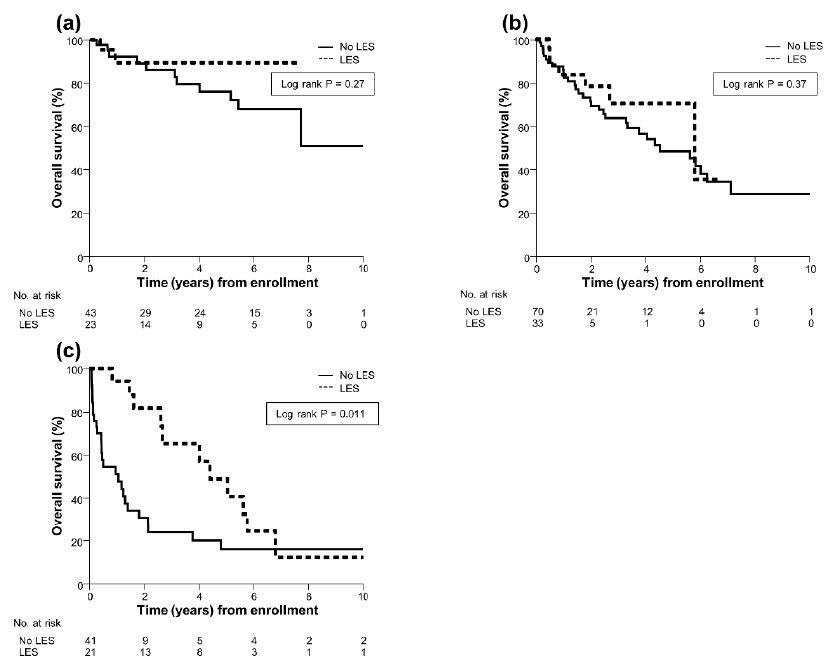
Figure 2. ( a ) Overall survival of 23 LES-treated patients and 43 untreated patients with Child–Pugh A cirrhosis. ( b ) Overall survival of 33 LES-treated patients and 70 untreated patients with Child–Pugh B cirrhosis. ( c ) Overall survival of 21 LES-treated patients and 41 untreated patients with Child–Pugh C cirrhosis. Overall survival was estimated using the Kaplan–Meier method and compared between groups using the log-rank test. LES, late evening snack. groups using the log-rank test. LES, late evening